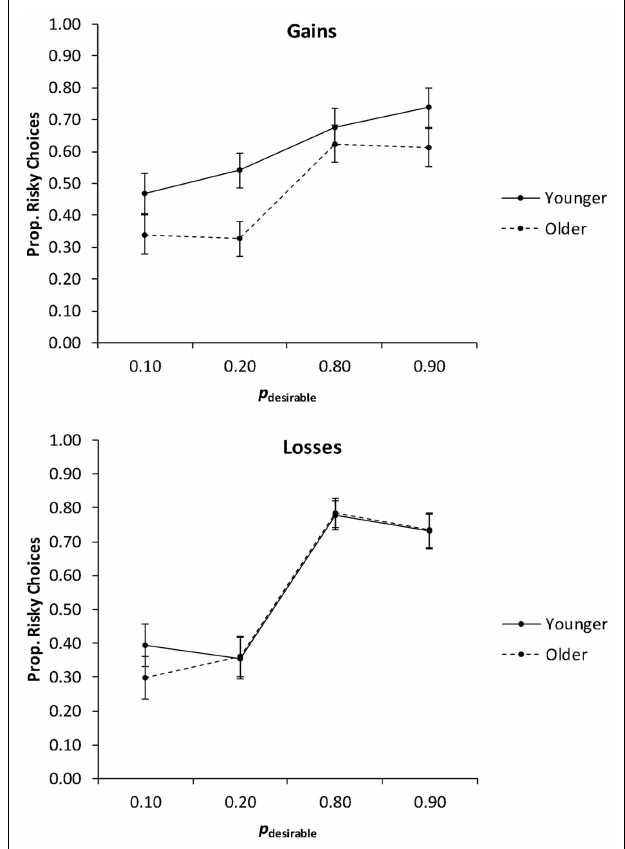
FIGURE 3 | Sampling frequency as a function of valence and payoff variability, for younger and older adults. Adjusted means for the average level of the covariate (years of education) are shown. Error bars indicate SEM.